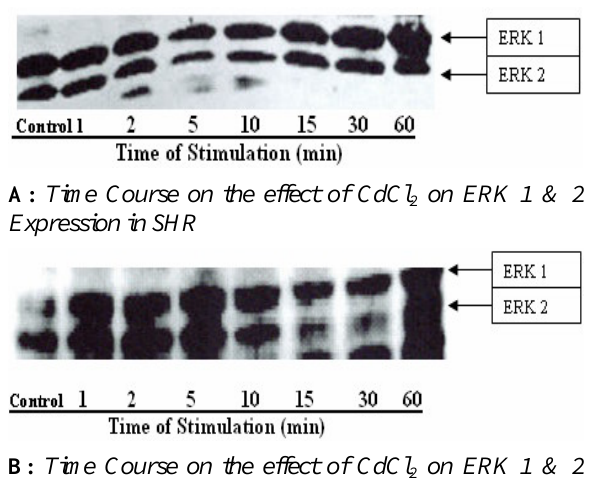
Figure 3: A time course effect of CdCl of ERK 1 & 2 in VSMCs of (A) SHR and (B) WKY rats. VSMCs were stimulated with 4 µM of CdCl specified time 1-60 min. Cell were harvested in lysis buffer as described in Material and Methods, and equal protein concentrations (20 µg) for each sample were analyzed on a 10% polyacrylamide gel and transferred to a nitrocellulose membrane. ERK 1 & 2 were determined by measuring specific phosphorylated ERK 1 & 2 (pp44 ERK-1 and pp42 ERK-2) by western blot.